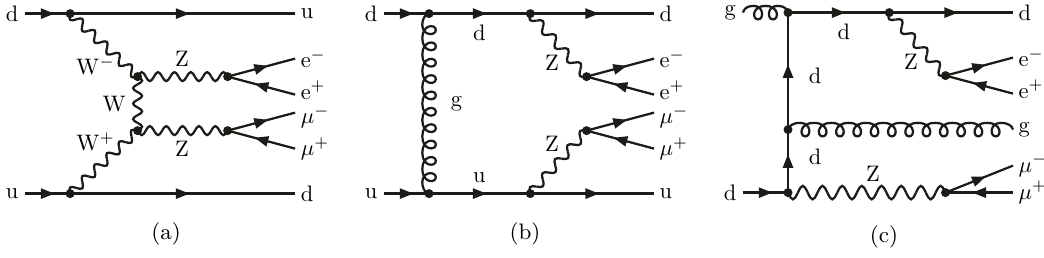
Figure 1 . Examples of tree-level Feynman diagrams: EW (left) and QCD (middle and right). Feynman diagrams of order O (cid:0) g 6 (cid:1) and O (cid:0) g 2 gluons appear (see figure 1c) with all possible crossings of gluons and